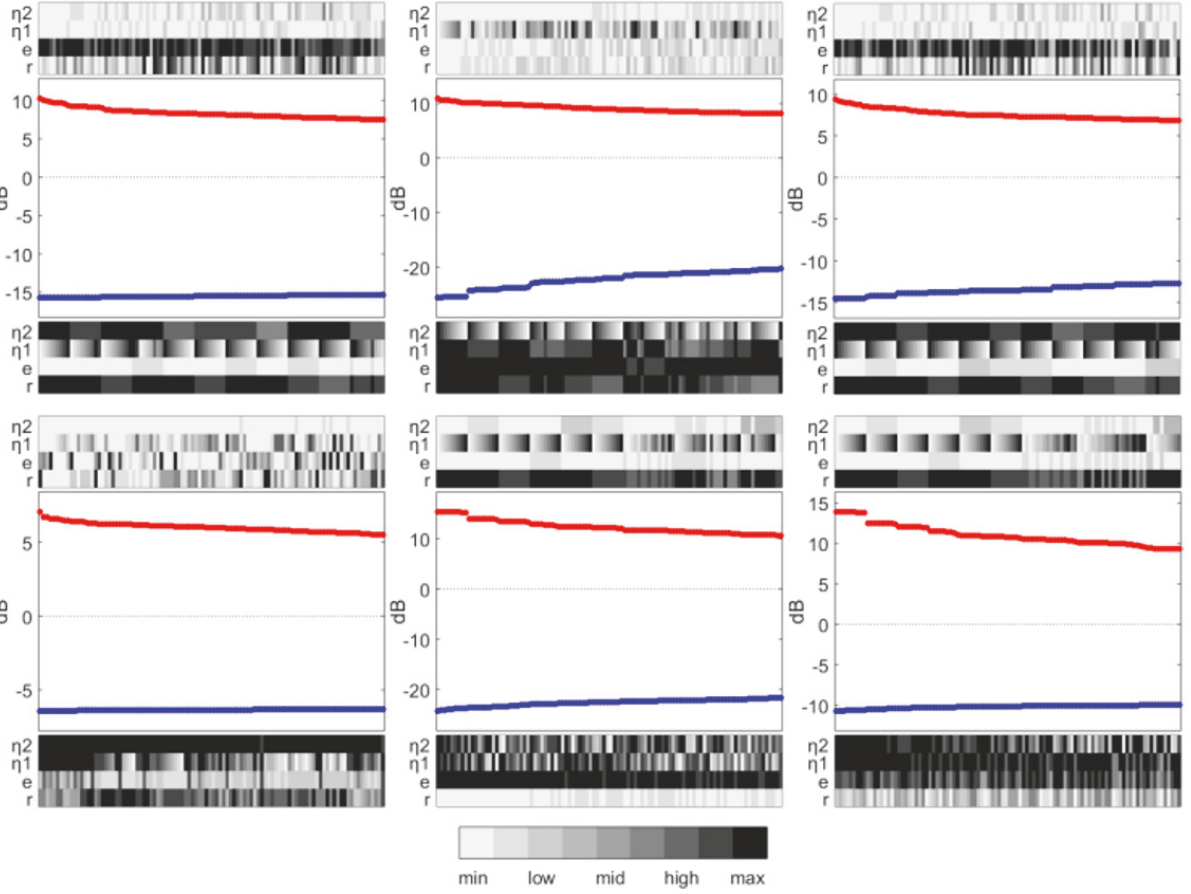
Figure 2: Normalised kinetic energy levels of a two-degrees-of-freedom system. Top: force excitation; bottom: kinematic excitation. Left: subsystem 1; middle: subsystem 2; right: entire